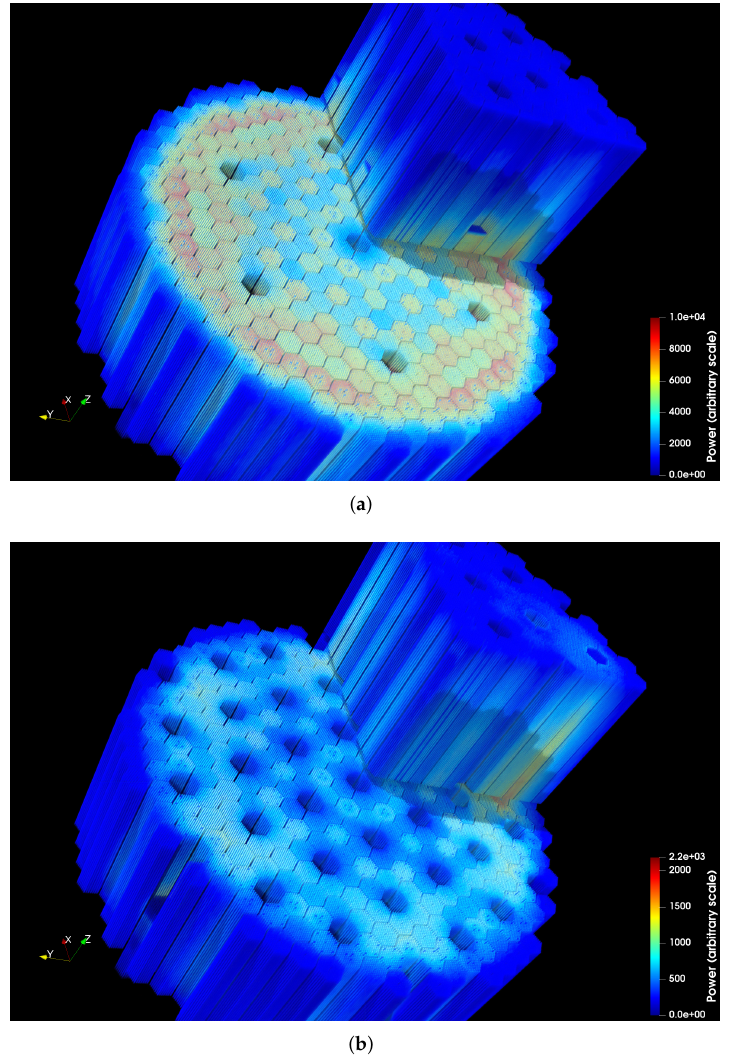
Figure 8. Power distribution at 5 s ( a ) and at 9 s ( b ) into the transient.